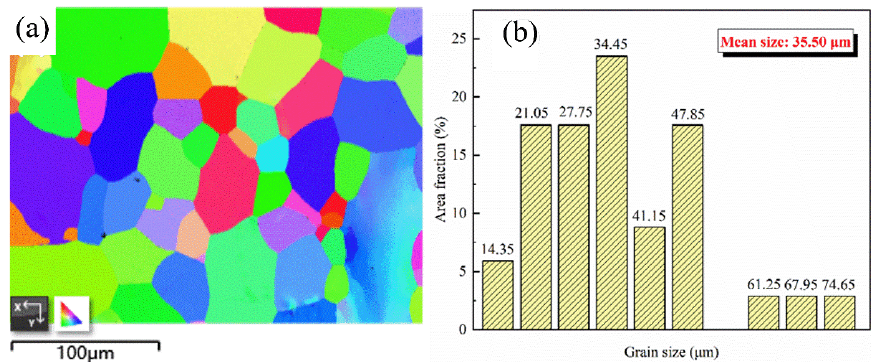
Figure 7. 800 °C annealing alloy: ( a ) EBSD image; ( b ) grain size statistics.